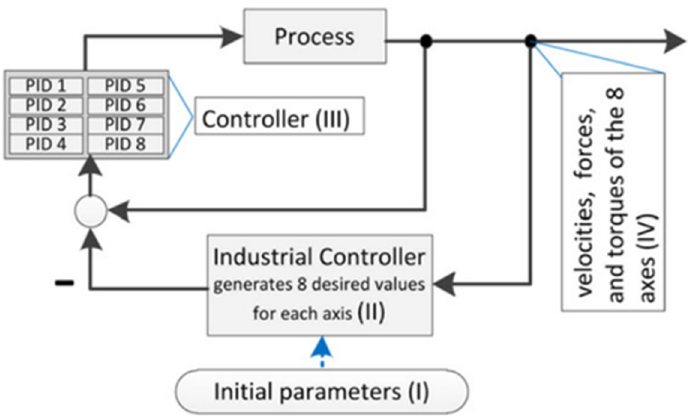
Figure 6. Feedback control of ring rolling process with permission from [52], 2012, Elsevier.